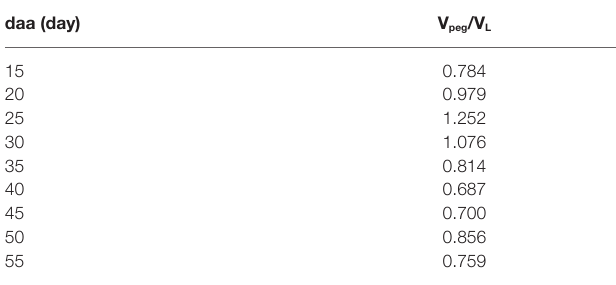
TABLE 1 | Invagination degree (V peg /V L ) values for tomato Cascada cuticles as a function of fruit development time